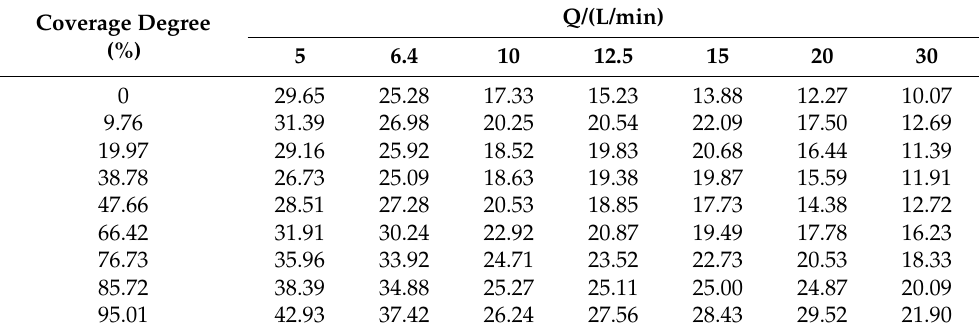
Table 3. Residence time corresponding to different flows under different coverage